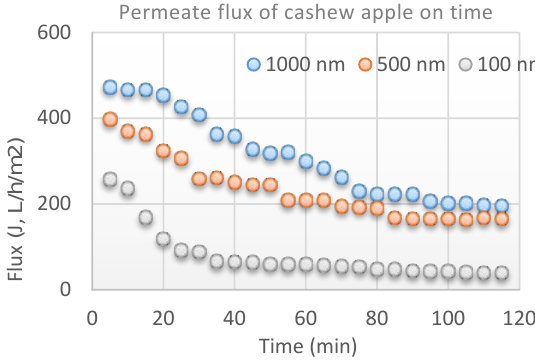
Figure 2. Permeate flux of cashew apple juice on time with different membrane pore sizes ( T = 30 °C; transmembrane pressure (TMP) = 2 bars).